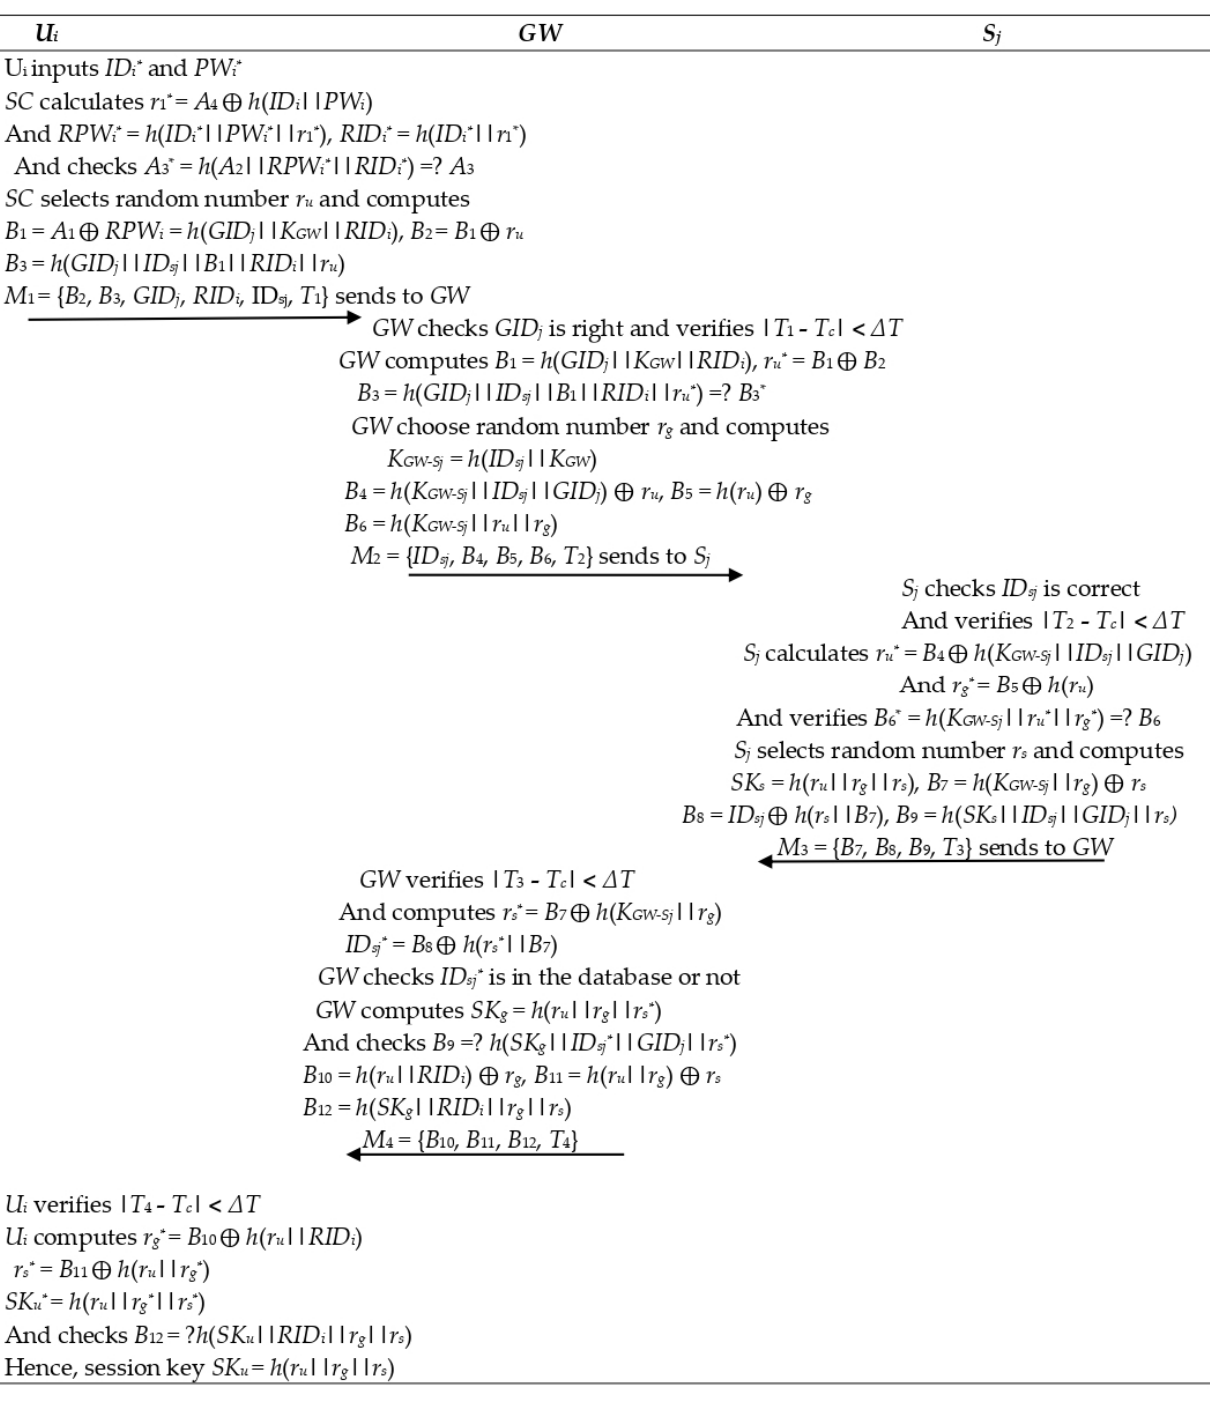
Figure 8. Authentication and key agreement phase.